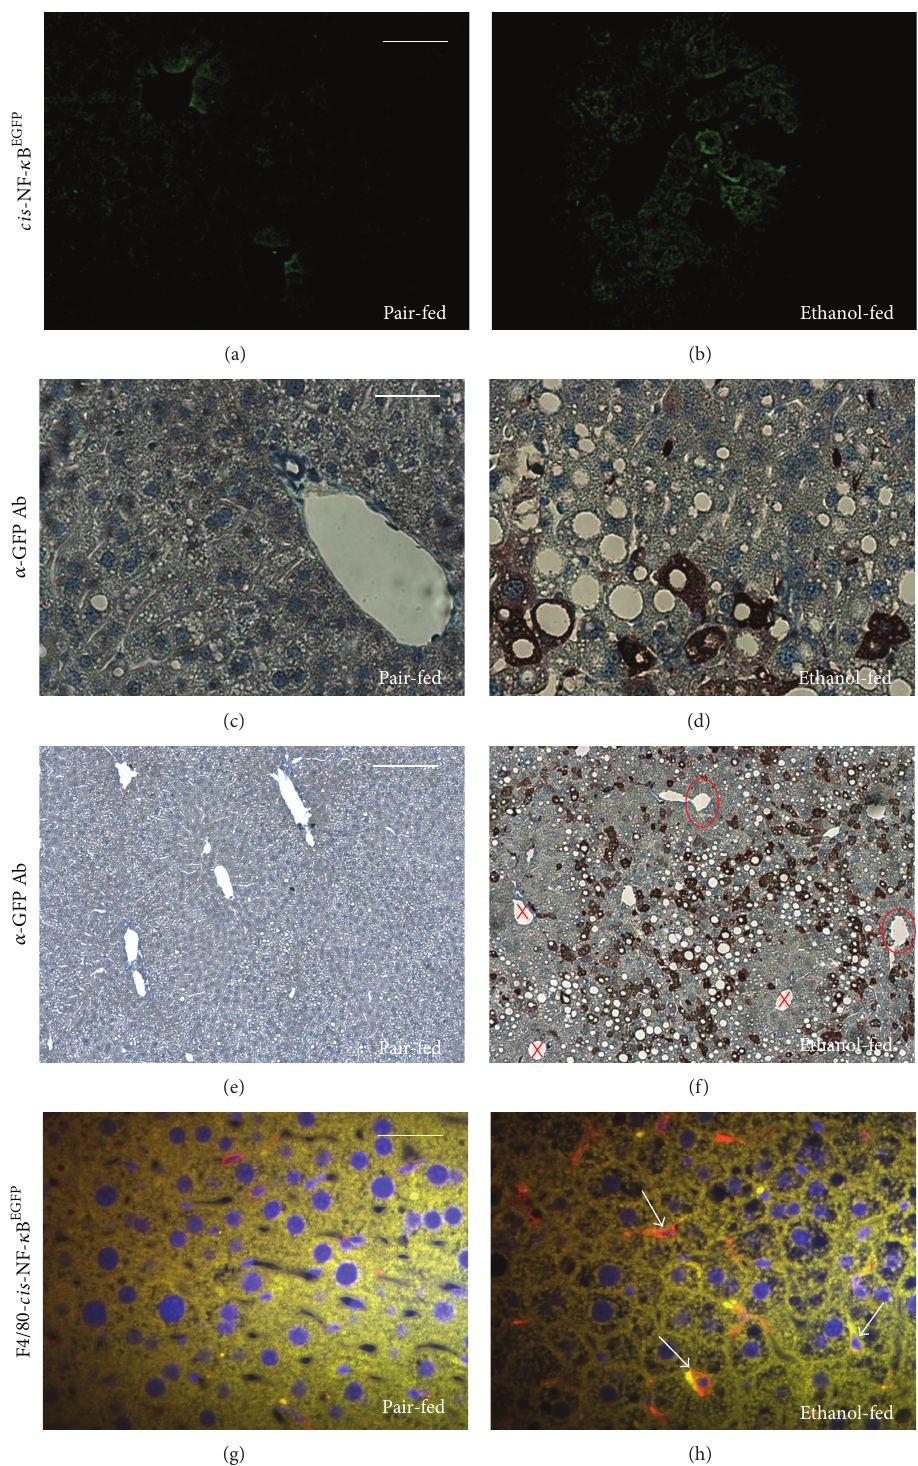
Figure 4: Effect of chronic ethanol on hepatic topography of cis -NF- 𝜅 B EGFP transcriptional induction and hepatic macrophage activation of NF- 𝜅 B dependent EGFP expression was analyzed using fluorescence microscopy in livers harvested from cis -NF- 𝜅 B EGFP mice and prepared as described in Section 2. Representative liver lobes from pair-fed ((a), (c), (e), and (g)) and ethanol-fed ((b), (d), (e), and (h)) mice are shown. Green fluorescence by EGFP represents NF- 𝜅 B activity ((a), (b): bar equals 100 𝜇 m). Additional GFP antibody staining identifies the topography of NF- 𝜅 B activation ((c), (d): bar equals 50 𝜇 m; (e), (f): bar equals 200 𝜇 m). The encircled areas mark central veins; the crosses mark portal fields. Immunostaining for F4/80 (red fluorescence) identifies Kupffer cells in cis -NF- 𝜅 B EGFP mice livers; overlay images show colabeled cells, marked by arrows ((g), (h): bar equals 20 𝜇